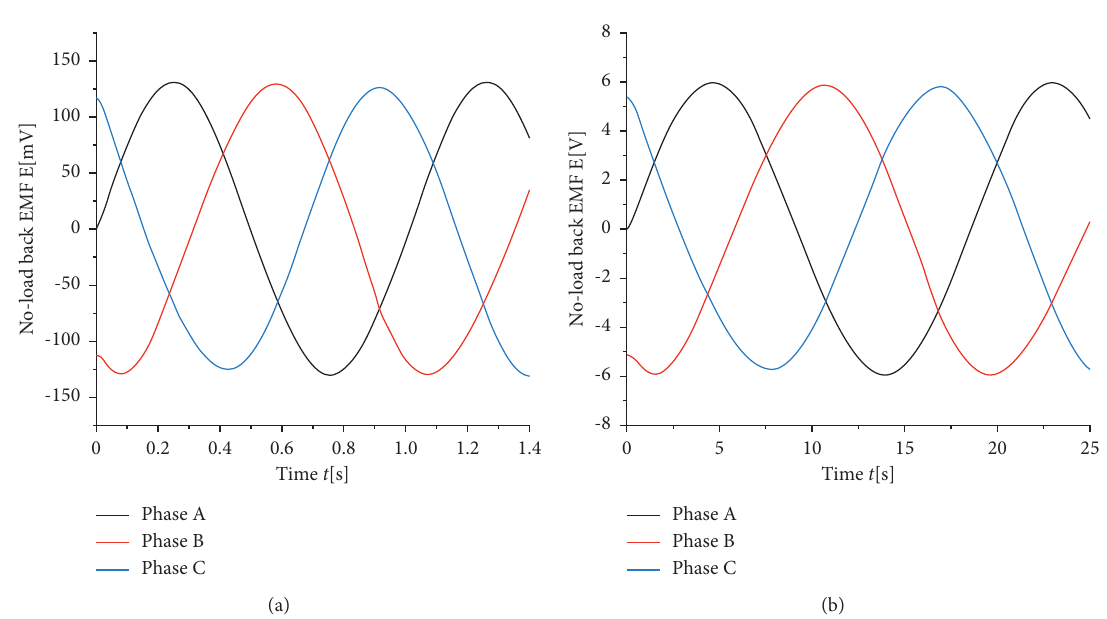
Figure 9: Waveform diagram of no-load back EMF of the new motor at different speeds: (a) v � 0.02m/s; (b) v � 1 m/s.